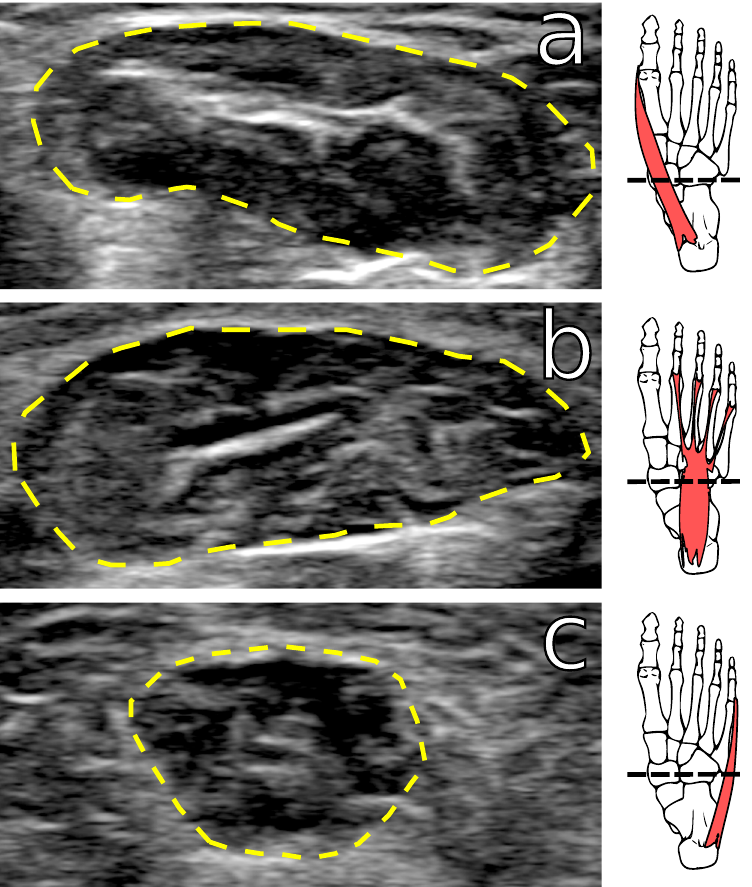
Figure 2. Examples of muscle cross-sectional area images taken using ultasound. ( a ) Abductor hallucis, ( b ) flexor digitorum brevis, and ( c ) abductor digiti minimi. Dashed line in foot skeleton illustrations indicates plane in which images were taken, based on palpation of the navicular